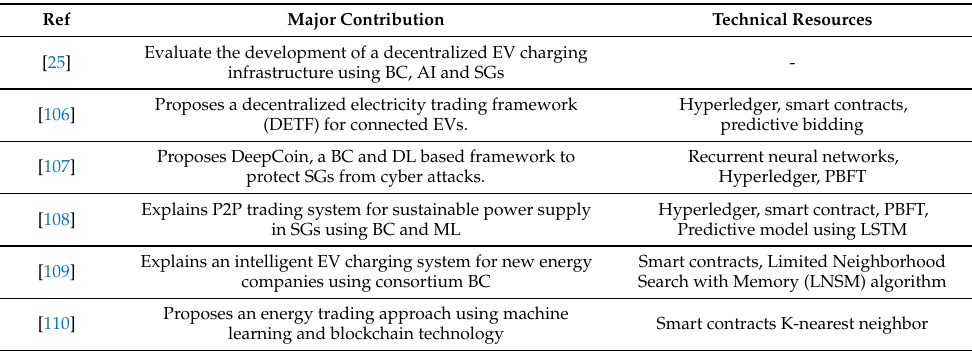
Table 9. Summary of existing works related to BC, ML and